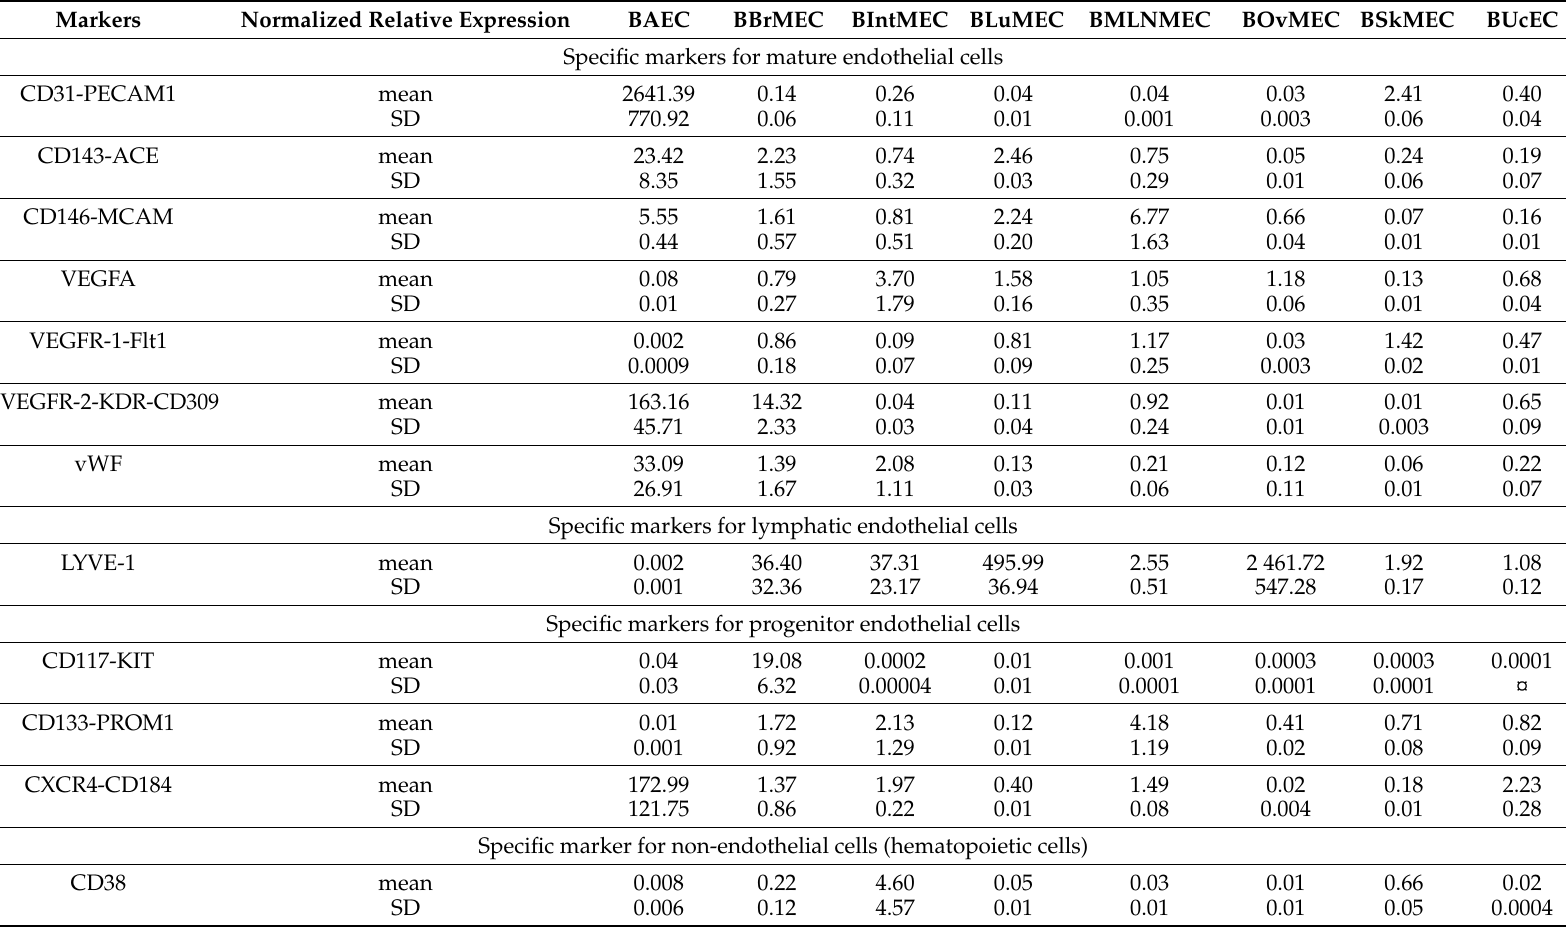
Table 2. Evaluation of specific RNA marker expression by RT-qPCR in bovine endothelial cell lines and bovine aortic primary endothelial cells (BAEC).